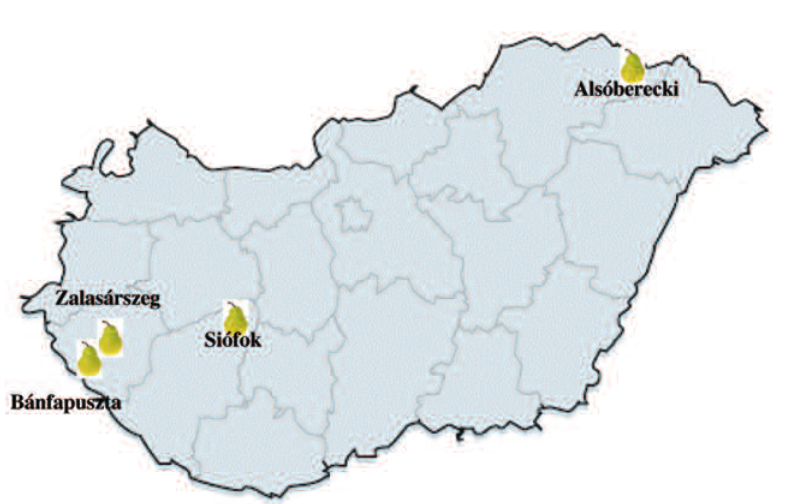
Figure 2. The examined